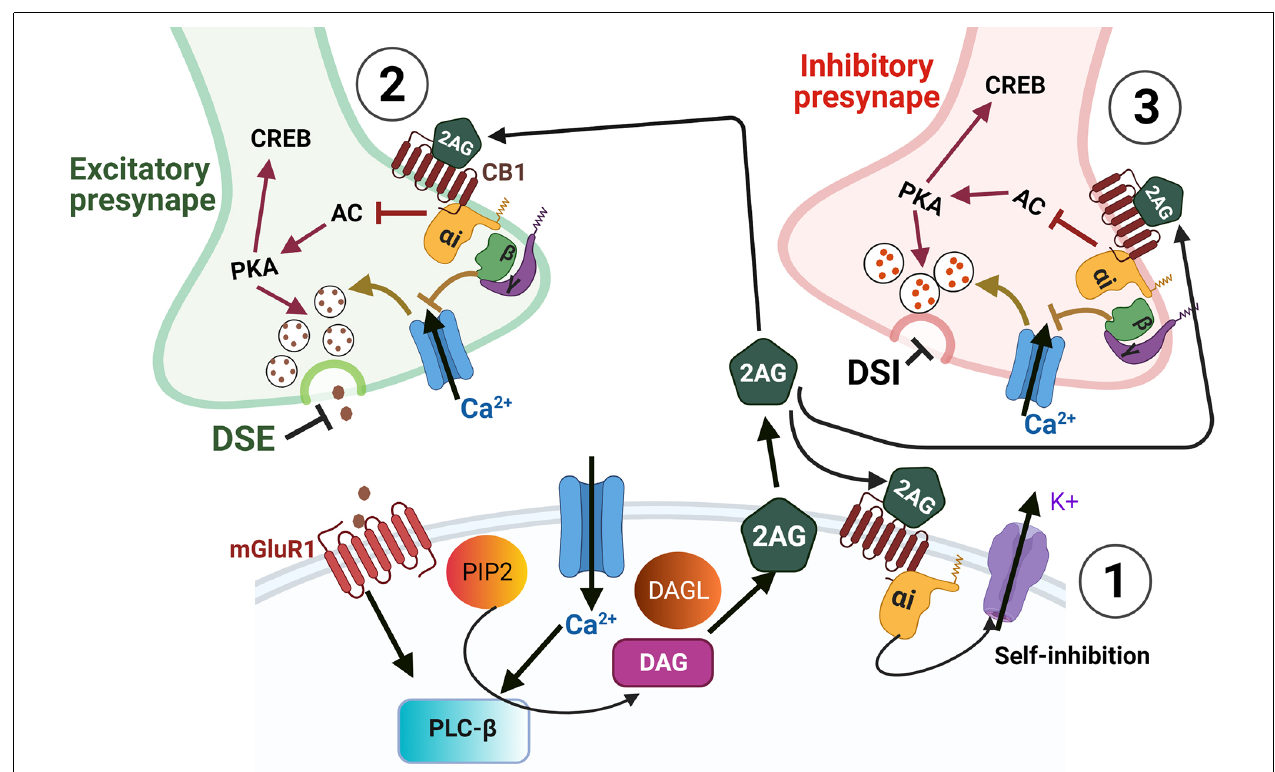
FIGURE 3 | Endocannabinoid-mediated synaptic suppression. Depolarization and/or calcium influx into a postsynaptic cell leads to endocannabinoid synthesis. ECS ligands are then released into the extracellular space where they can bind cell autonomously to membrane-bound CB receptors (1) , or to receptors on presynaptic cells (2,3) , or to receptors on glial processes (not shown). Cell autonomous binding of ECS ligands (1) can modulate the strength of post-synaptic responses by self-inhibition via potassium efflux. In presynaptic terminals (2,3) ECS ligands bind to CB receptors which are Gi/o-coupled GPCRs. The binding of these GPCRs leads to Gi/o- α receptor subunit detachment from βγ subunits. The detached Gi/o- α then inhibits adenylate cyclase (AC), which would otherwise drive cAMP-mediated activation of PKA and CREB. However, with AC inhibited the decreased activation of PKA results in decreased vesicle release of neurotransmitters. The presynaptic release is also inhibited by the βγ subunits which inhibit Ca 2 + entry that would also otherwise drive neurotransmitter release. When inhibitory neurotransmitters are prevented from being released by ECS it is termed depolarization-induced suppression of inhibition (DSI) and when ECS acts on excitatory presynaptic boutons, the inhibition of vesicle release is termed depolarization-induced suppression of excitation (DSE). In addition to DSI and DSE, the inhibition of AC and PKA can lead to decreased activation of CREB thus altering the expression of CREB dependent genes. Furthermore, the GPCR subunits and their effects on PKA and PKC can also activate either MAPK or PI3K signaling cascades to regulate gene expression (see Figure 2